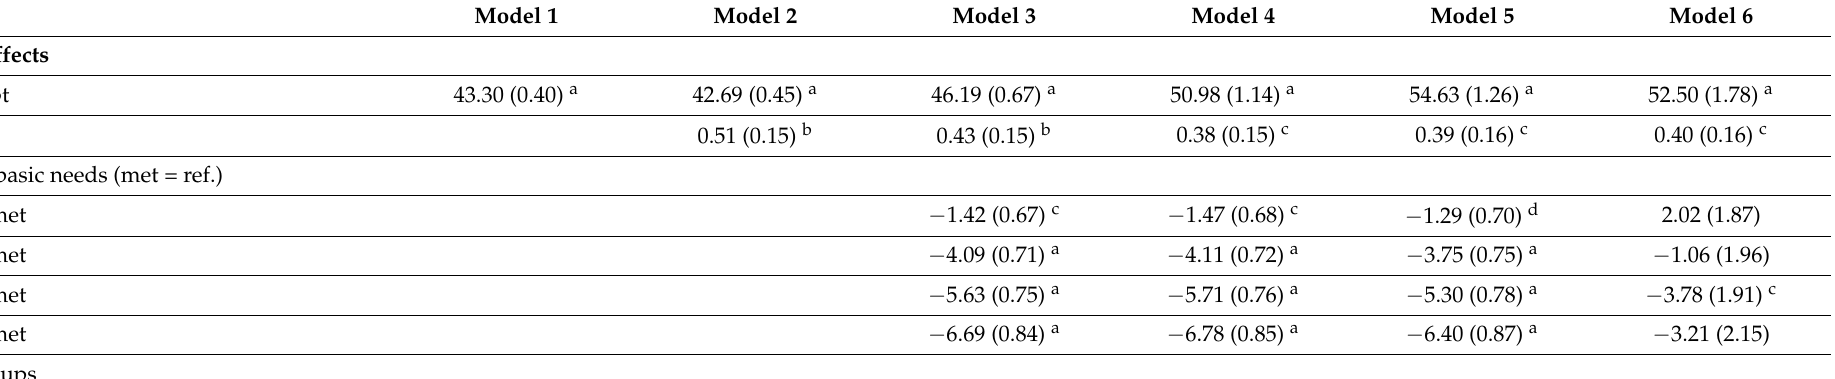
Table 2. Individual growth curve models for changes in Physical Health Summary (2006–2009) in Positive Spaces, Healthy Places (n =